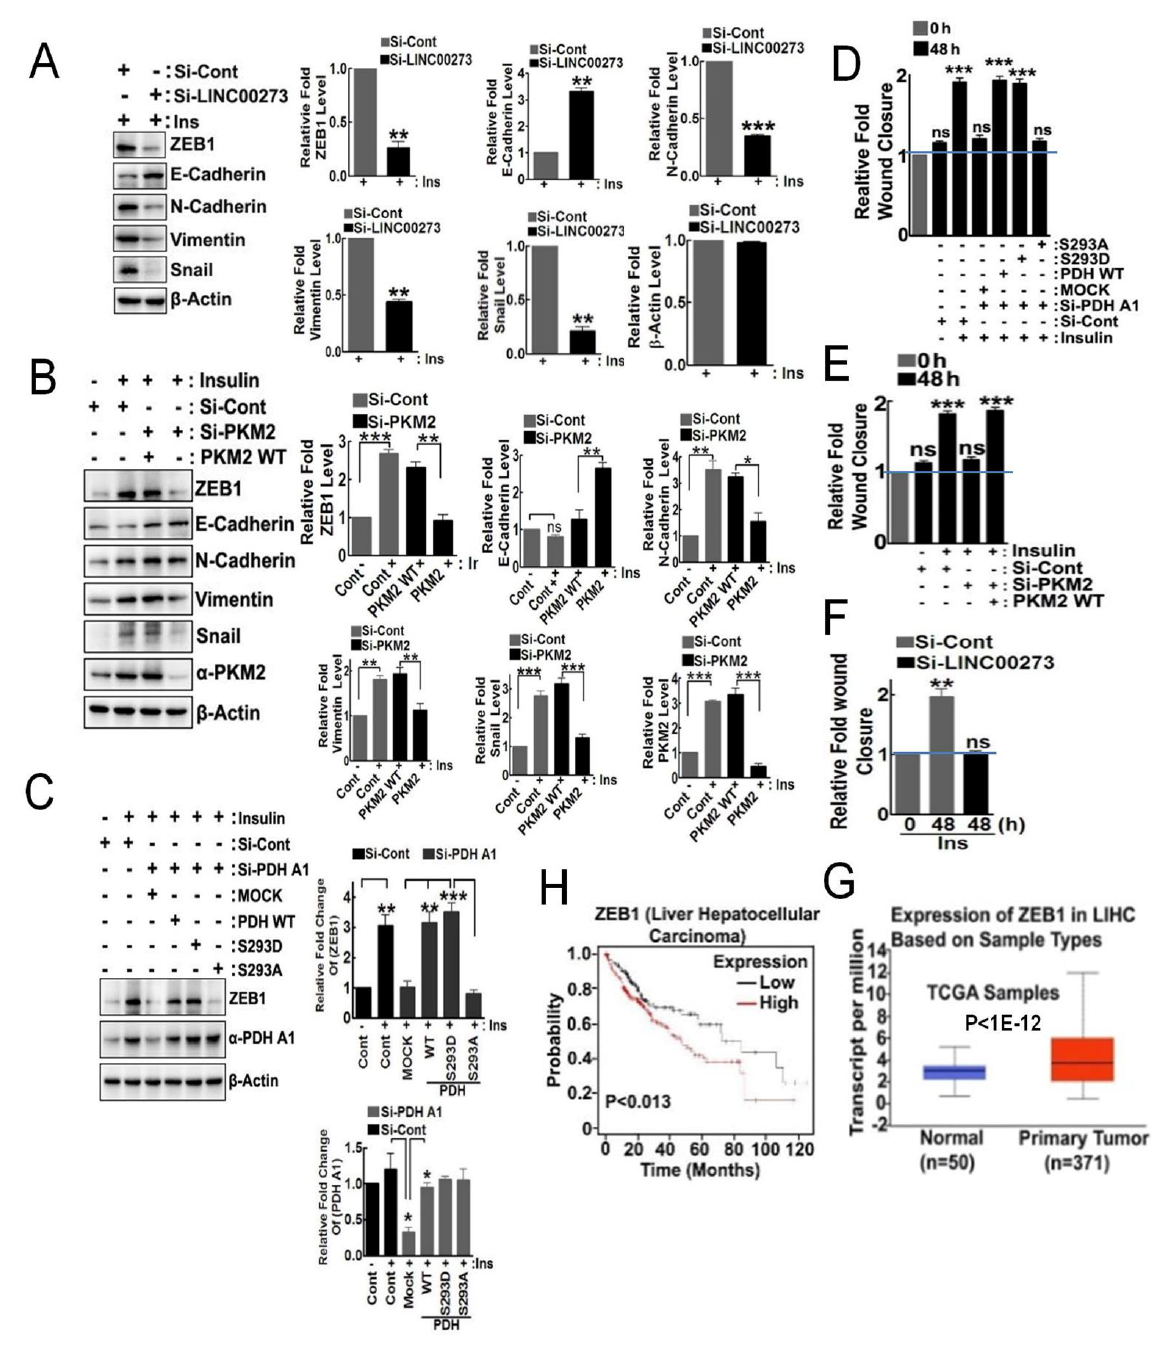
Figure 4. LINC00273 regulates ZEB1 expression and cell migration . ( A ) HepG2 cells were trans- fected with si-LINC00273 upon 100 nM insulin (100 nM for 48 h), and expression changes of ZEB1, E-cadherin, N-cadherin, vimentin, and Snail were determined by immunoblotting and plotted in bar diagram. ( B ) HepG2 cells were si-PKM2 transfected with PKM2 WT addback and expression and stimulated with insulin (100 nM for 48 h), and modulations of ZEB1, E-cadherin, N-cadherin, vimentin, and Snail were determined by immunoblotting and represented as bar diagram. ( C ) si- PDHA1 was transfected into HepG2 cells, and PDHA1 WT, S293D, or S293A was addback to the cells, which were stimulated with 100 nM insulin (100 nM for 24 h), and the expression changes for